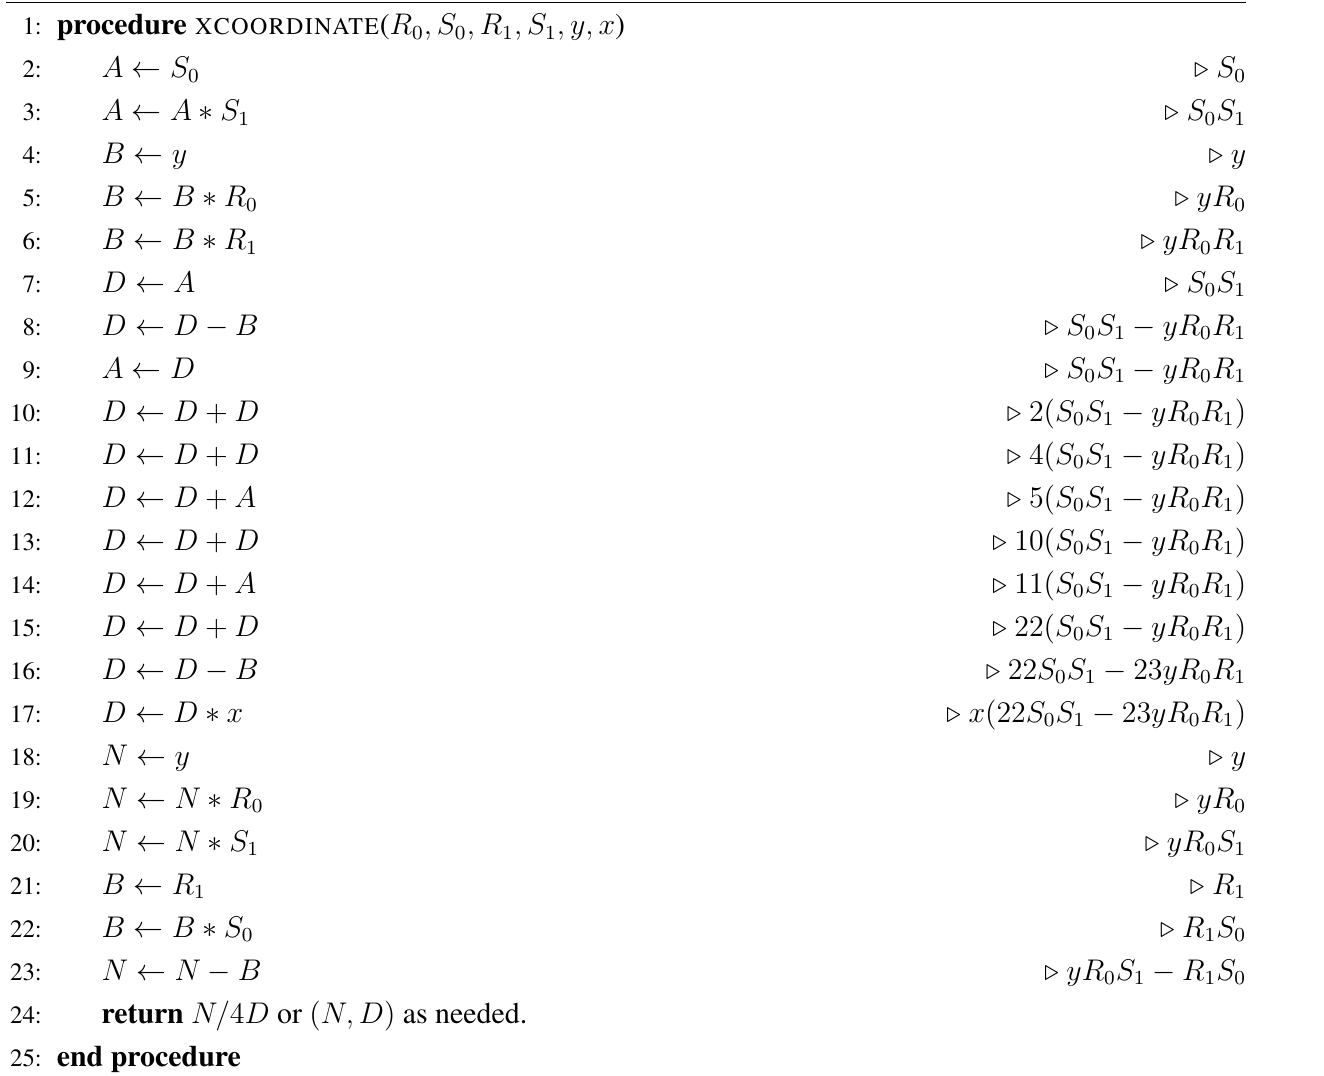
Algorithm 3 Computing the x -coordinate of scalar multiplication when both original coordinates are